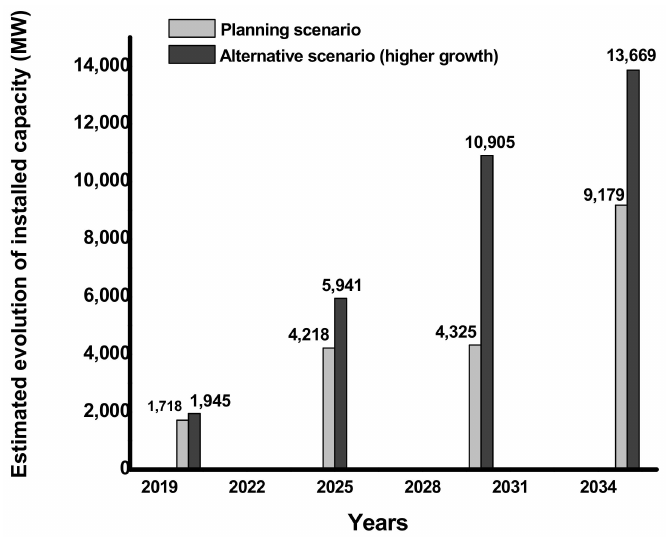
Figure 3. Estimated evolution of distributed generation capacity installed in Mexico, 2016–2035 in MW